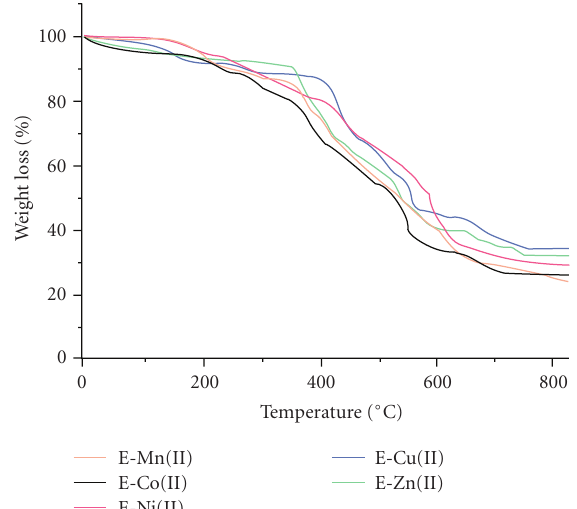
Figure 3: Thermogram of metal-chelated epoxy polymers.